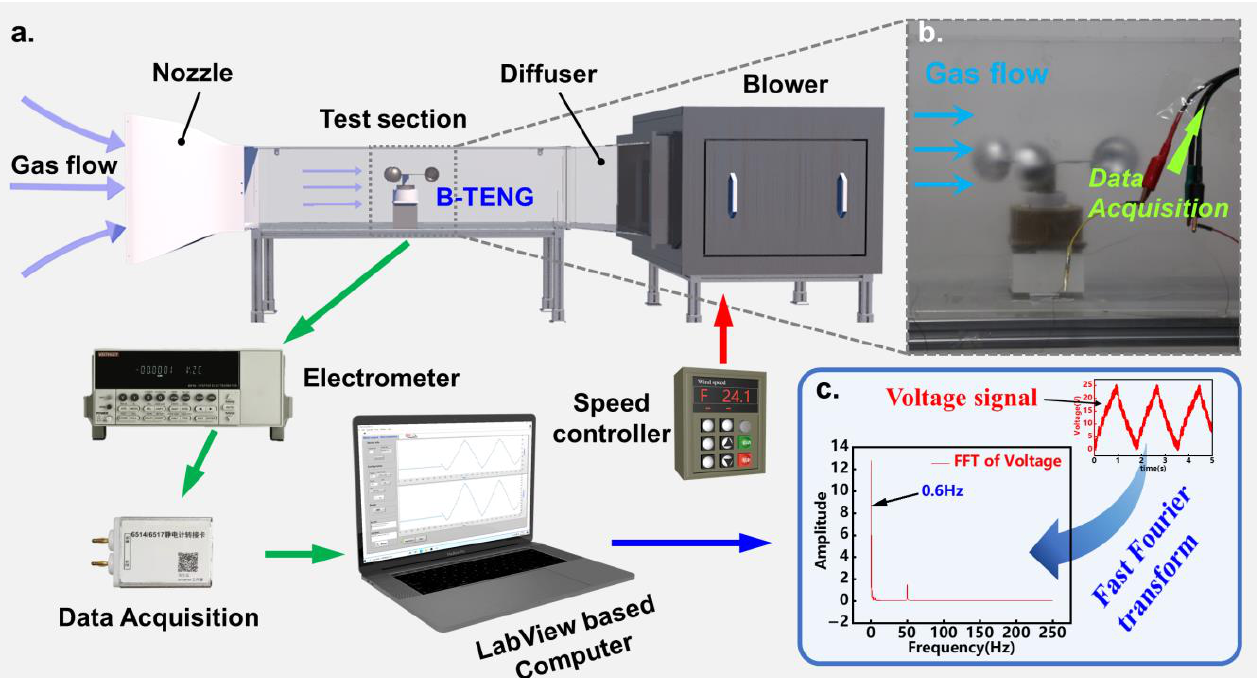
Figure 2. Output performance test system for the B-TENG. ( a ) test apparatus arrangement; ( b ) image of the B-TENG installed in the test section; ( c ) fast Fourier transform of the voltage signal.